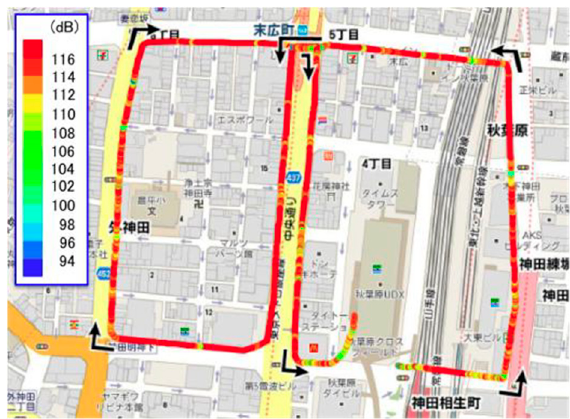
Figure 2. A 50 years old male participant with a rheumatoid and paralyzed arm moves his manual wheelchair. Although he tried to control his wheelchair carefully throughout this experiment, higher VAL values were detected at uneven road surfaces.